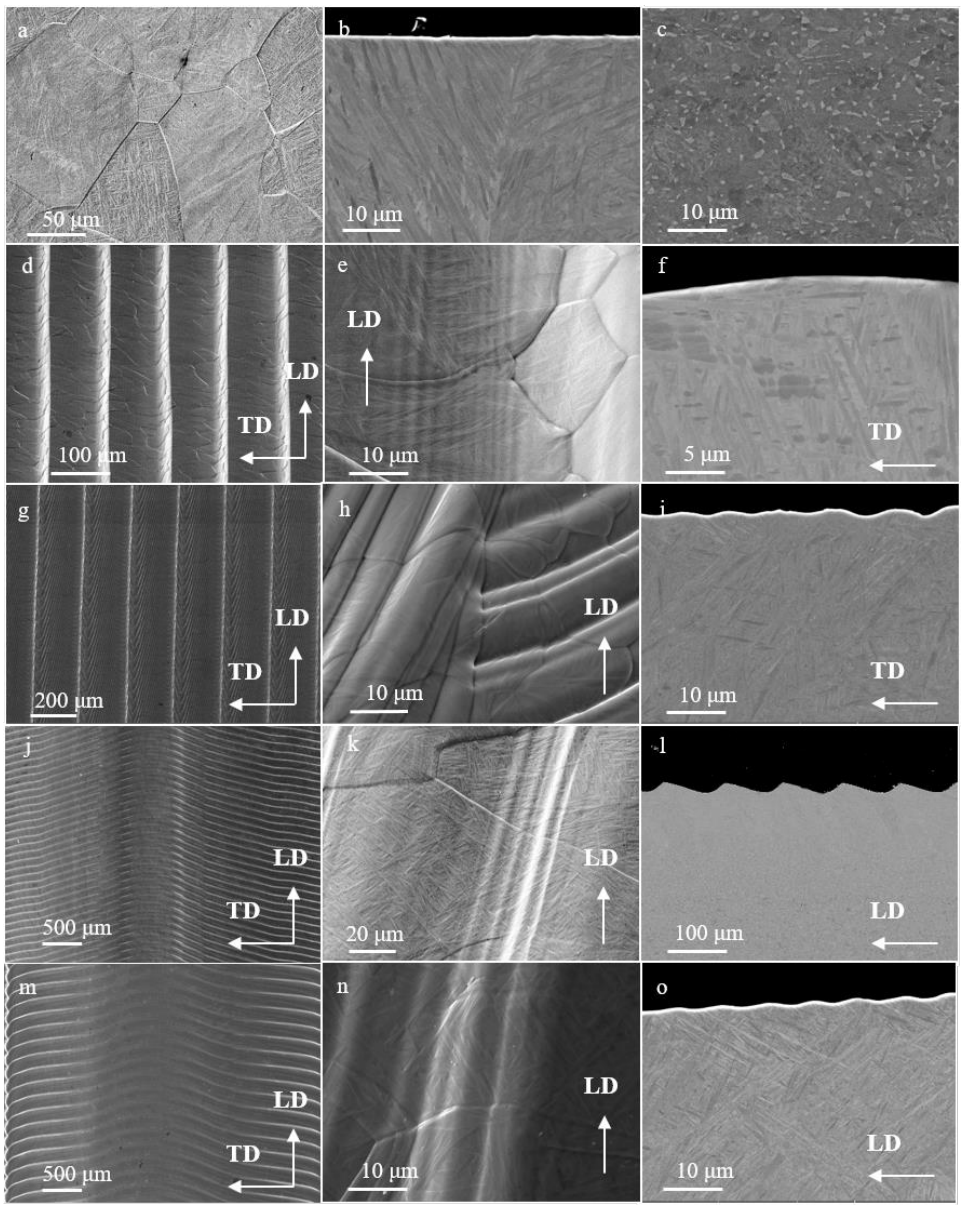
Figure 5. Surface and cross-section SEM images of the bare EB structures: ( a – c ), M; ( d – f ), G1; ( g – i ), G2; ( j – l ), B1; and ( m – o ), B2. ( d , g , j , m ) correspond to an overview of the structures. ( e , h , k , n ) correspond to detail images of the EB surfaces. ( f , i ) TD cross-section of G1 and G2. ( l , o ) LD cross-section of B1 and B2 showing the cross-section of the micro-grooves.